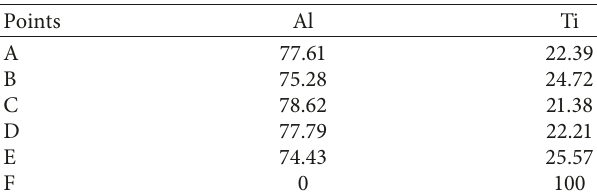
Figure 3: (a) Cross-sectional BSD image of Al coating after testing for 5 hours at 973K, and (b) the expanded view of region I in Figure 3(a). Table 2: The chemical composition (at.%) of different points, as marked in Figure 3(b).